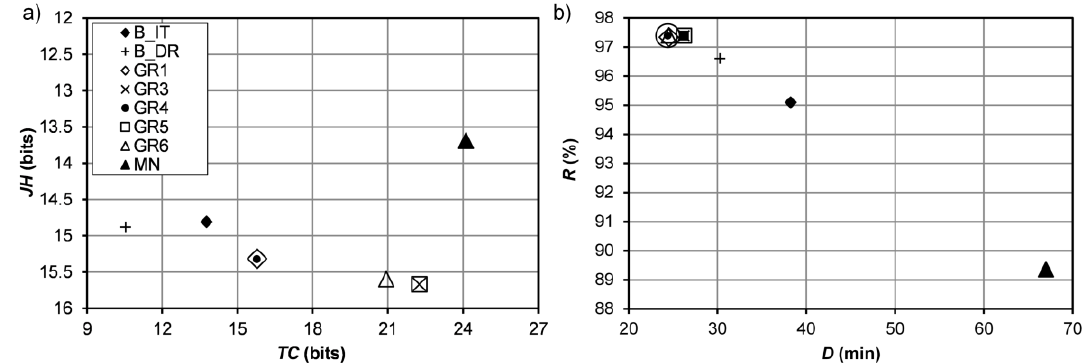
Figure 2. Objective function values obtained with the considered procedures ( a ) JH and TC objectives; ( b ) R and D objectives (12 sensors; detection threshold equal to 0.0001